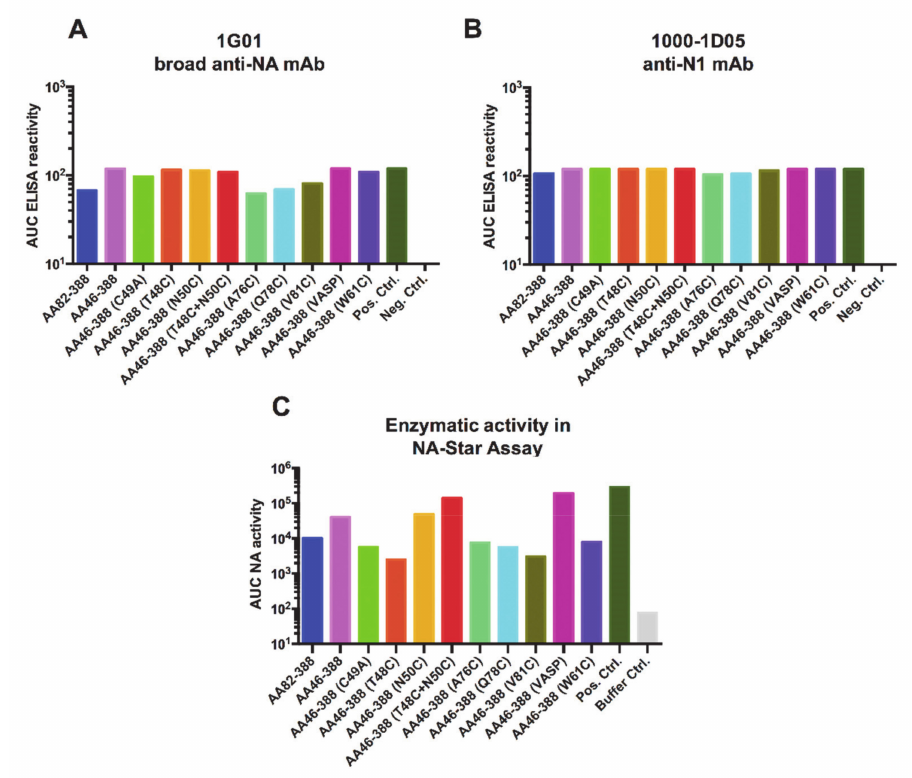
Figure 2. Antigenicity and enzymatic activity of recombinant NA constructs. ELISA plates were coated with recombinant NA proteins carrying the different stalk mutations. Binding of the broadly reactive NA monoclonal antibodies 1G01 ( A ) and 1000-1D05 ( B ) was tested. The enzymatic activity of the NA constructs was assessed using the NA-Star assay. ( C ). The tetrameric Mich15 N1 containing the VASP domain was used as a positive control (in all three panels), while mAb KL-AV-1A12 (anti-arenavirus glycoprotein mAb) was used as a negative control in ( A , B